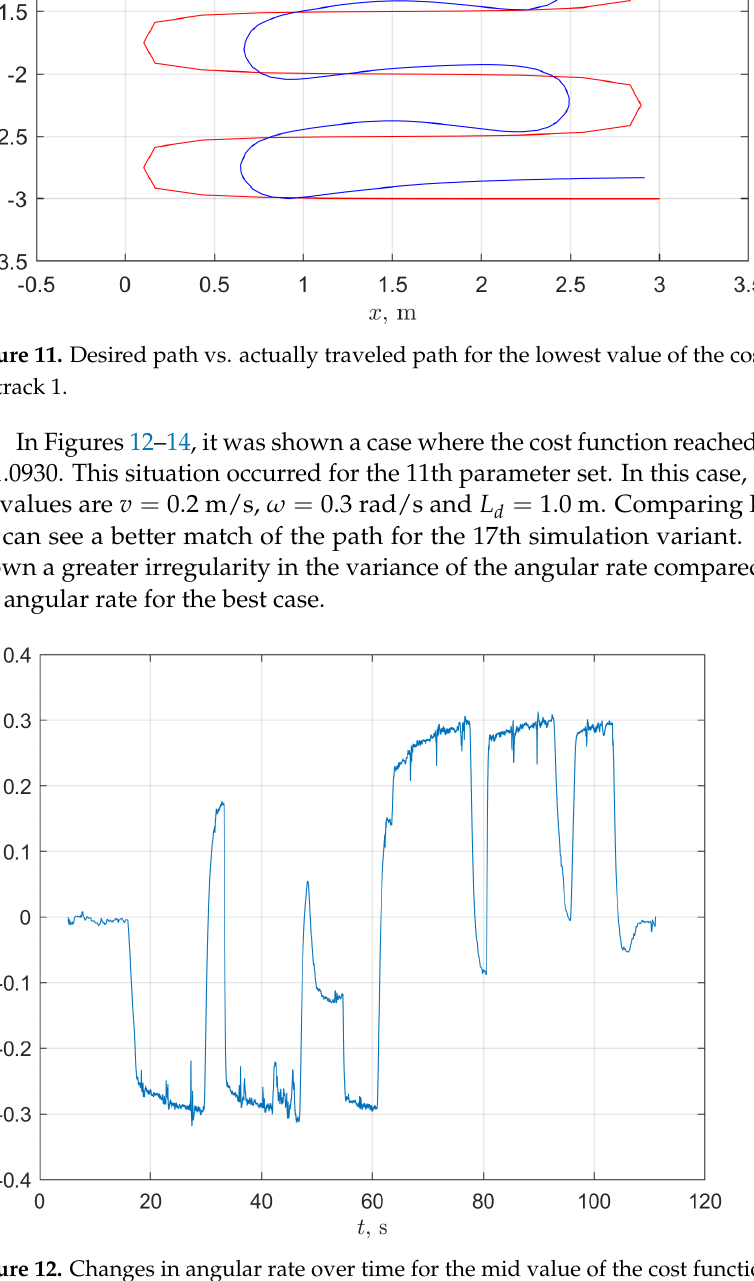
Figure 12. Changes in angular rate over time for the mid value of the cost function equal to 1.0930— track